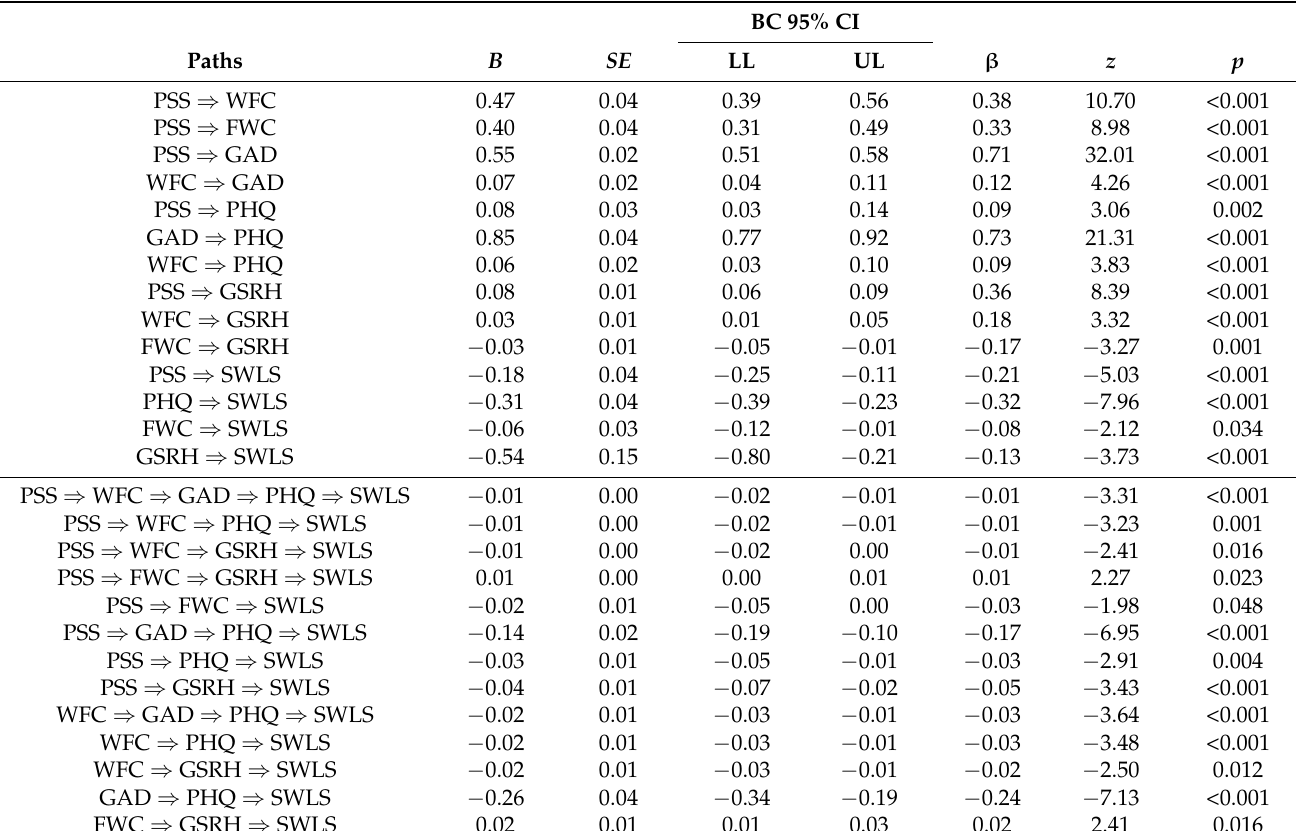
Table 4. The path model for life satisfaction ( N = 736).